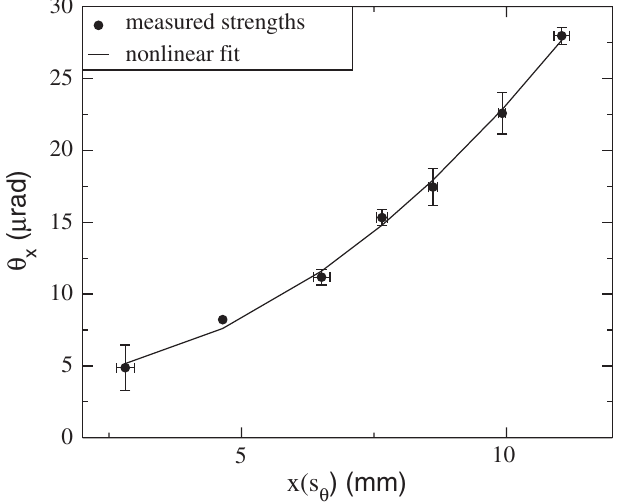
FIG. 11. Measured horizontal kick error as a function of the horizontal beam position for sextupole 63 in the SPS ring. Optimal turns of turn by turn difference orbits with seven differ- ent amplitudes were used to obtain this curve. A quadratic fit gave an integrated sextupole strength in good agreement with the actual set strength value (taken from Ref.